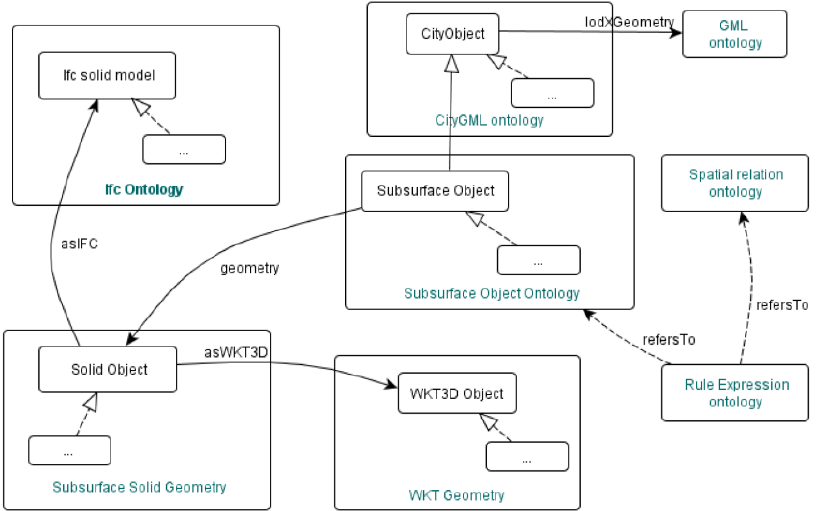
Figure 3. Minimal model (subsurface solid geometry) mapped to IFC and CityGML, from Métral [24].